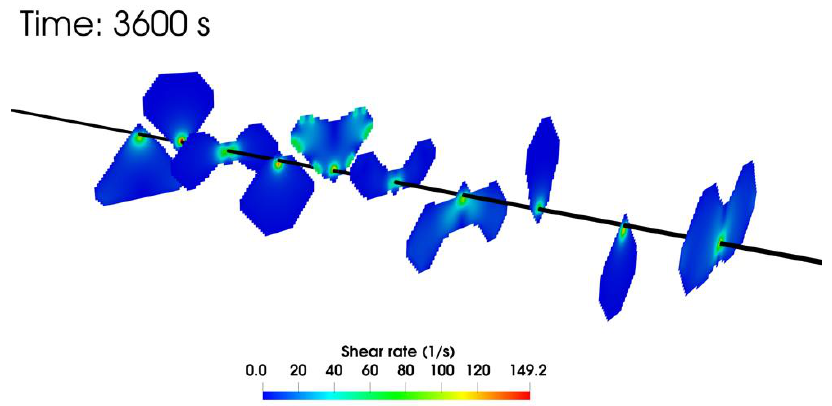
Figure 11. Shear rate within the fractures at the end of injection for the NG foam case.